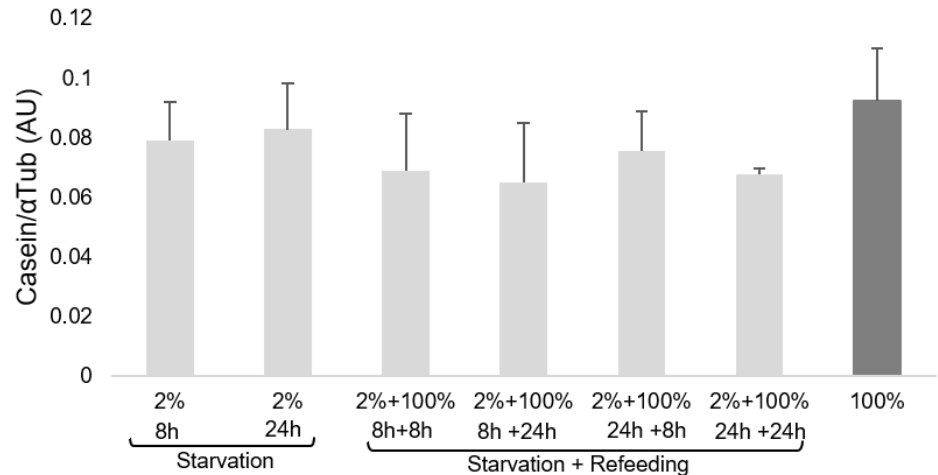
Figure 1. Casein expression in MECs (mean ± SD). Cells were cultured for 6 days after reaching confluence. EAAs were added at concentrations of 2% and 100% to DMEM for 8 and 24 h, followed by refeeding with 100% EAAs for 8 and 24 h. The dark gray column represents the average level of casein expression in cells not depleted (100% EAA, control) and cultured for 8, 24, and 48 h. MEC: mammary epithelial cell; SD: standard deviation; EAA: essential amino acid.